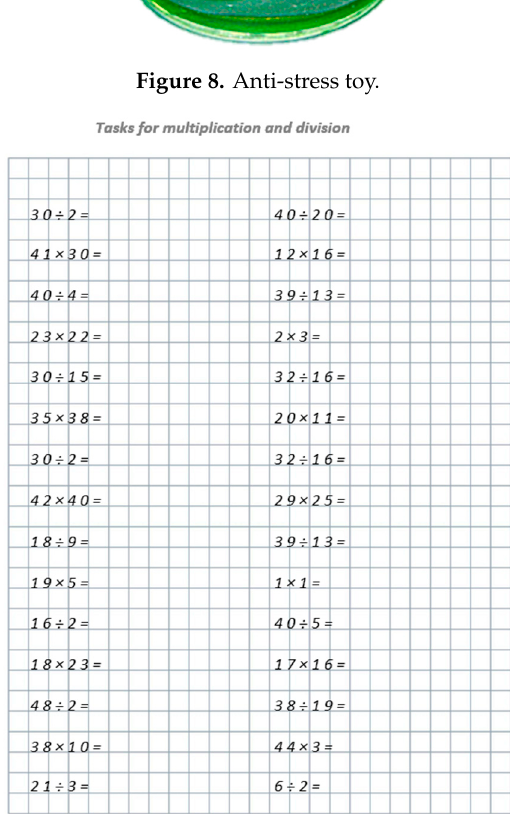
Figure 9. Examples of calculating tasks.